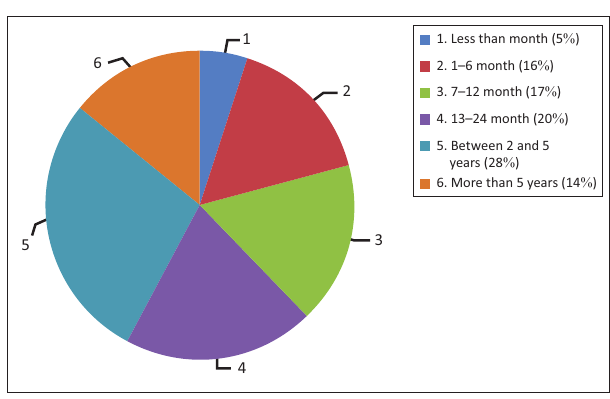
FIGURE 7: Internet banking passwords are not changed